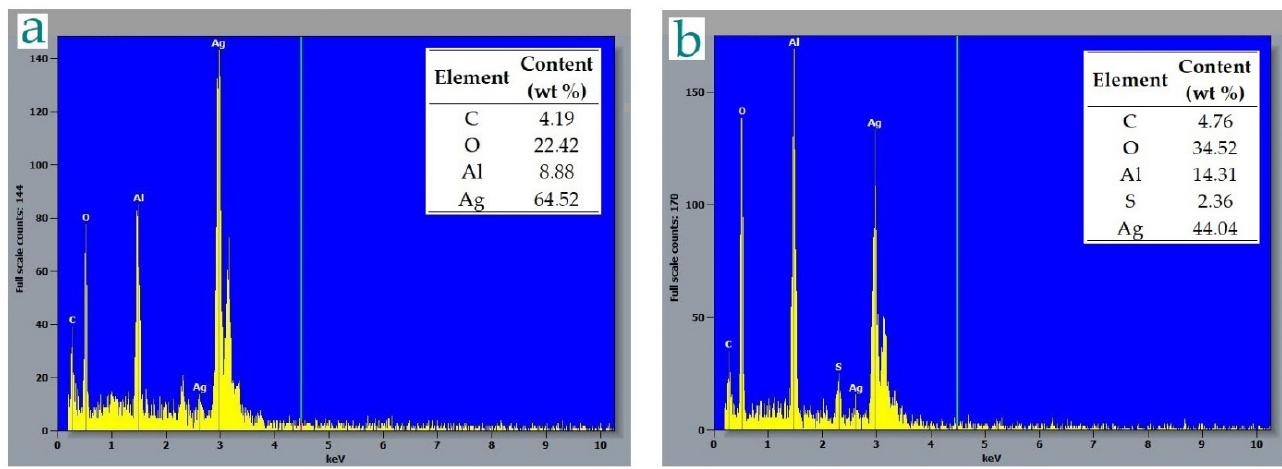
Figure 6 . Microphotographs of samples of groups ( a ) AE-0.5, ( b ) AE-8, ( c ) BE-0.5, and ( d ) BE-8.